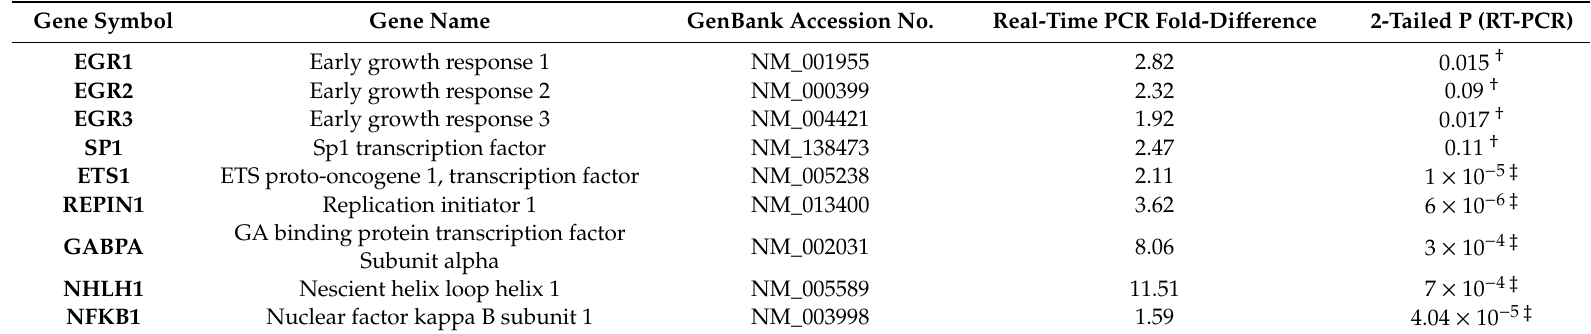
Table 1. Transcription factors found to be upregulated in peripheral blood mononuclear cells (PBMC) of patients with Myalgic encephalomyelitis / chronic fatigue syndrome (ME / CFS) as compared with normal blood donors by real-time reverse transcriptase polymerase chain reaction (RT-PCR)